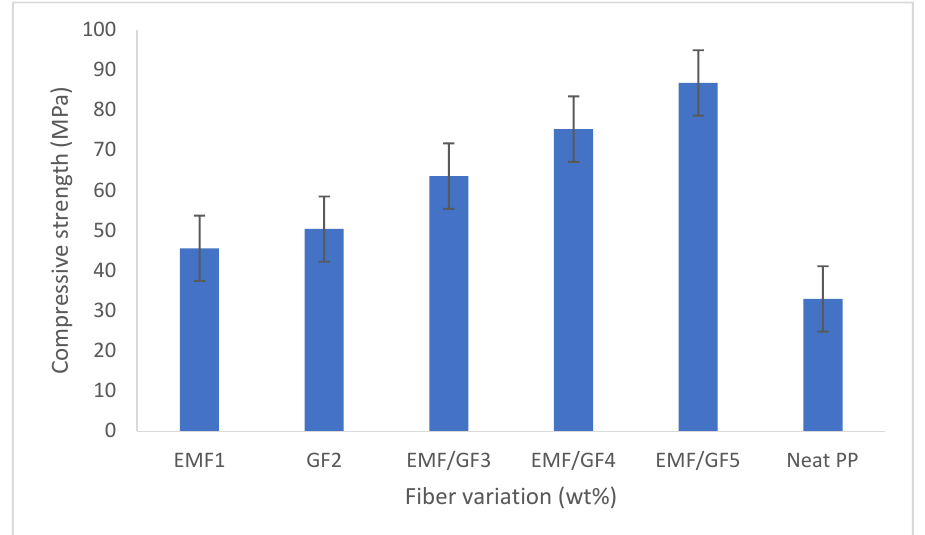
Figure 7. Compressive strength of the reinforced composites and pure PP.